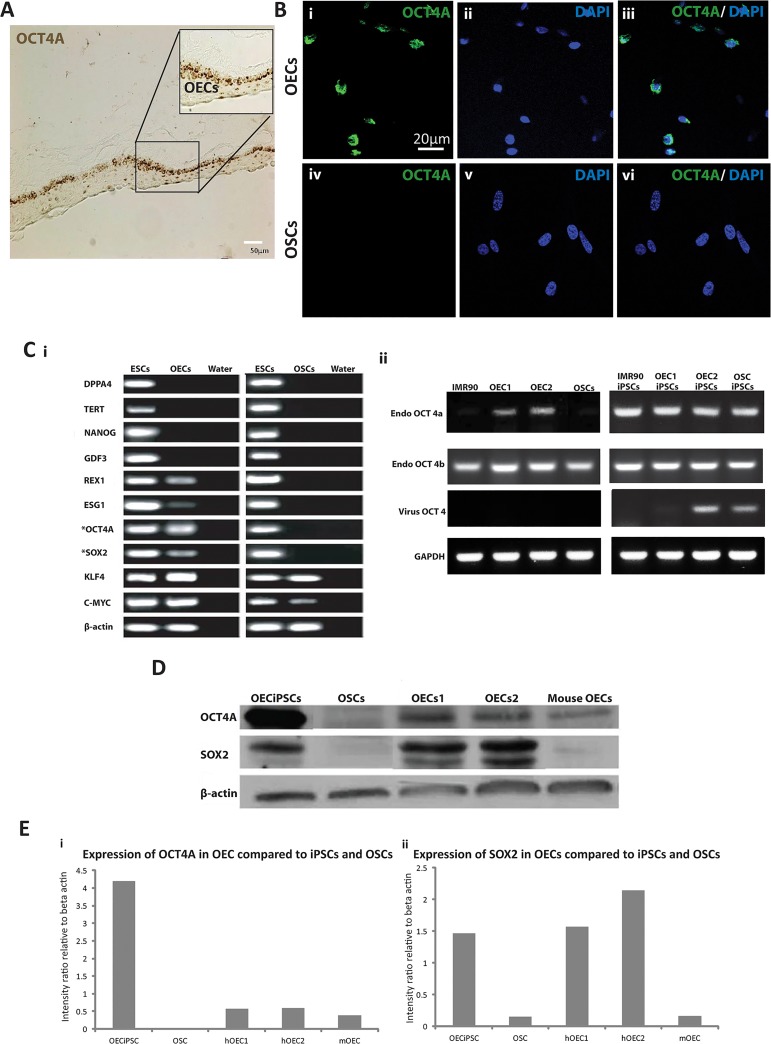
Endogenous expression of OCT4A and SOX2 pluripotency reprogramming factors in OECs derived from conjunctival tissues.
(A) DAB-based immunohistochemistry staining displayed the expression of OCT4A (brown, arrows) in human ocular sections. OCT4A expressed in the epithelium layer but not in stromal layers (OEL, ocular epithelial layer; OSL, ocular stromal layer). (B) Immunofluorescence staining demonstrated OCT4A expression in OECs but not in OSCs. (C) (i) Reverse transcription polymerase chain reaction (RT-PCR) results in expression of pluripotency genes (from top to bottom Panels): DPPA4, TERT, NANOG, GDF3, REX1, ESG1, OCT4A, SOX2, KLF4 and C-MYC and Beta- actin. Human ESCs and water were included as positive and negative controls respectively. (ii) Expression of OCT4 isoforms OCT4A and OCT4B, endogenous OCT 4 and viral OCT4 detecting using 5’ and 3’ UTR sequences tracking with RT-PCR. (From left to right) Primary lines (IMR90, OEC1, OEC2 and OSCs) and their corresponding iPSCs. (D) Western Blotting for OCT4A and SOX2 protein levels in OECs, OSCs and iPSCs. Lane 1: OECiPSCs, Lane 2: OSCs, Lane 3&4: OEC1&2 respectively, Lane 5: mouse OECs (E) Expression levels of (i) OCT4A and (ii) SOX2 were represented in intensity ratios respectively.